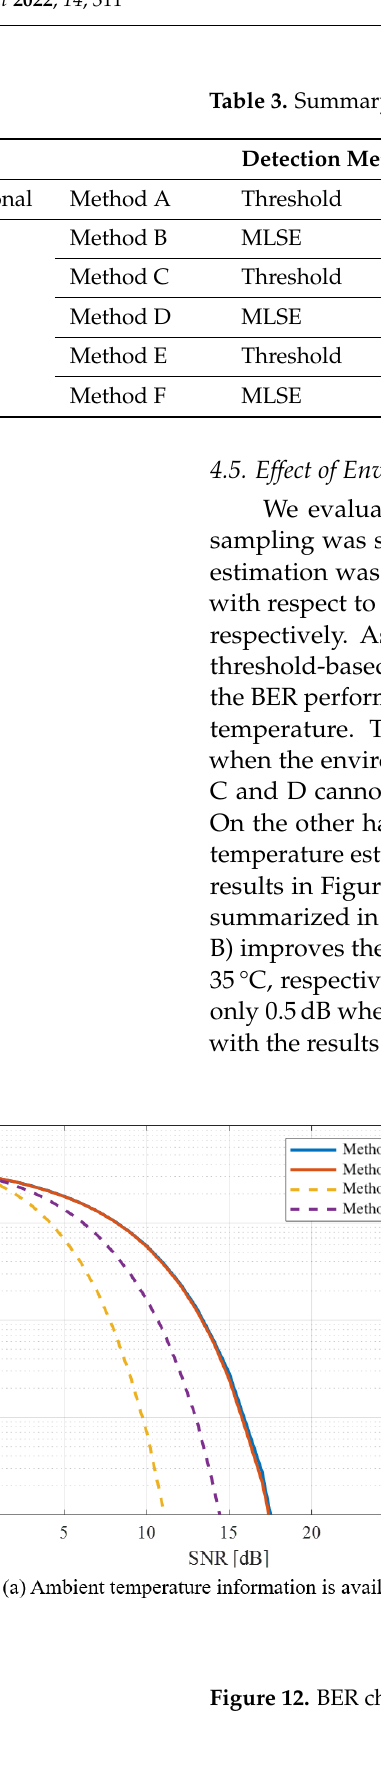
Figure 12. BER characteristics with respect to